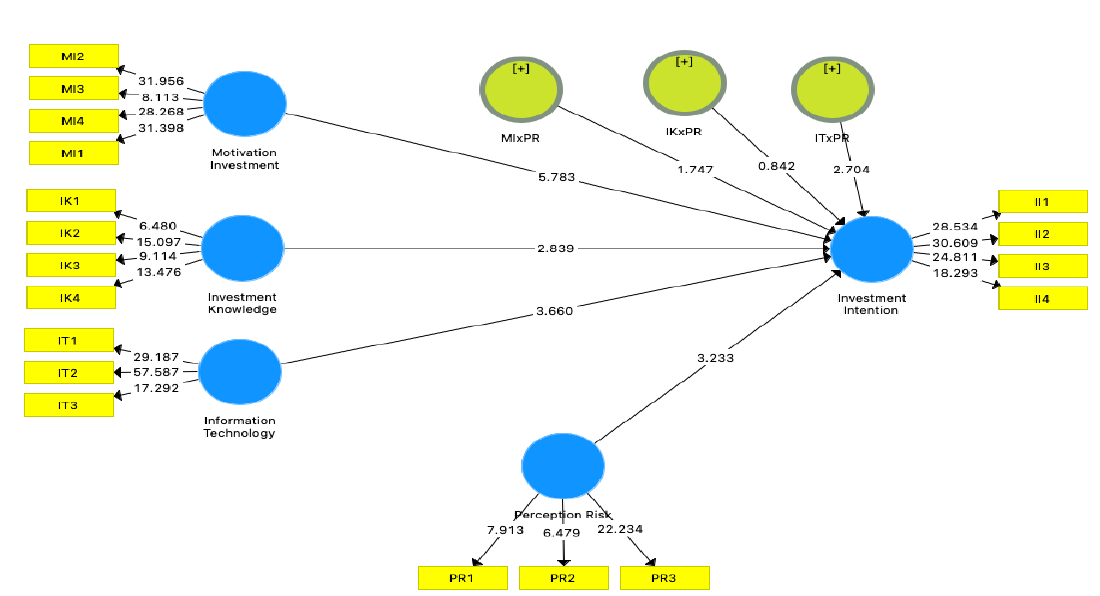
Figure 2: Conceptual Model of the Study; Source: Authors